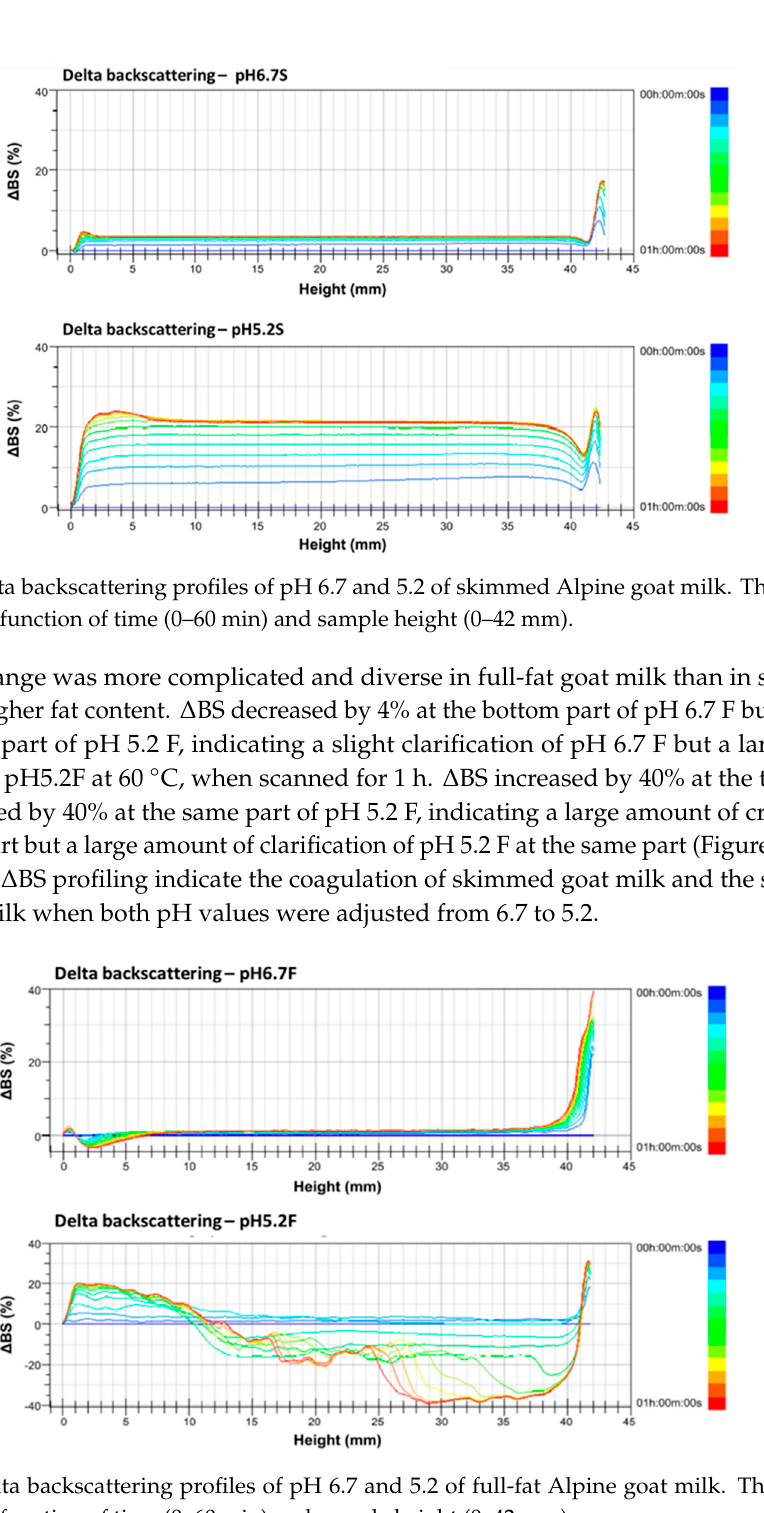
Figure 4. Delta backscattering profiles of pH 6.7 and 5.2 of full-fat Alpine goat milk. The data are reported as a function of time (0–60 min) and sample height (0–42